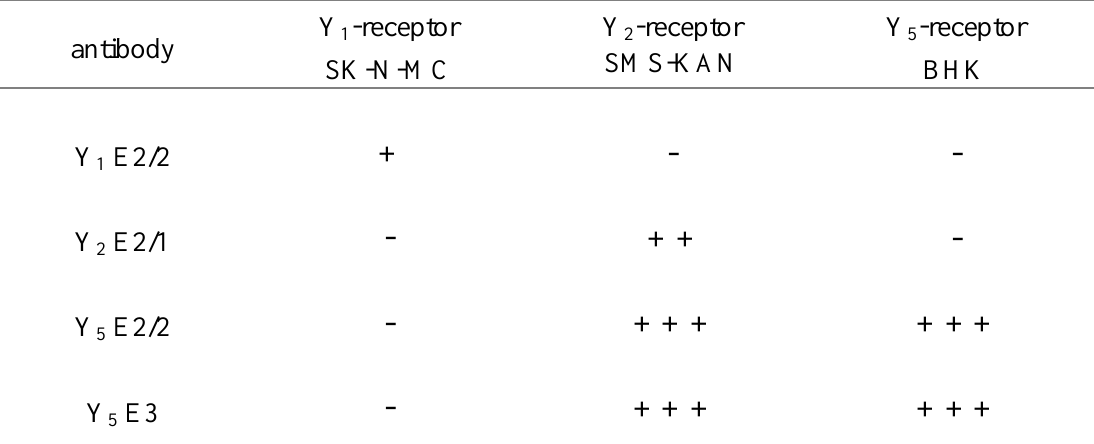
) and BHK cells (baby hamster kidney cells, 2